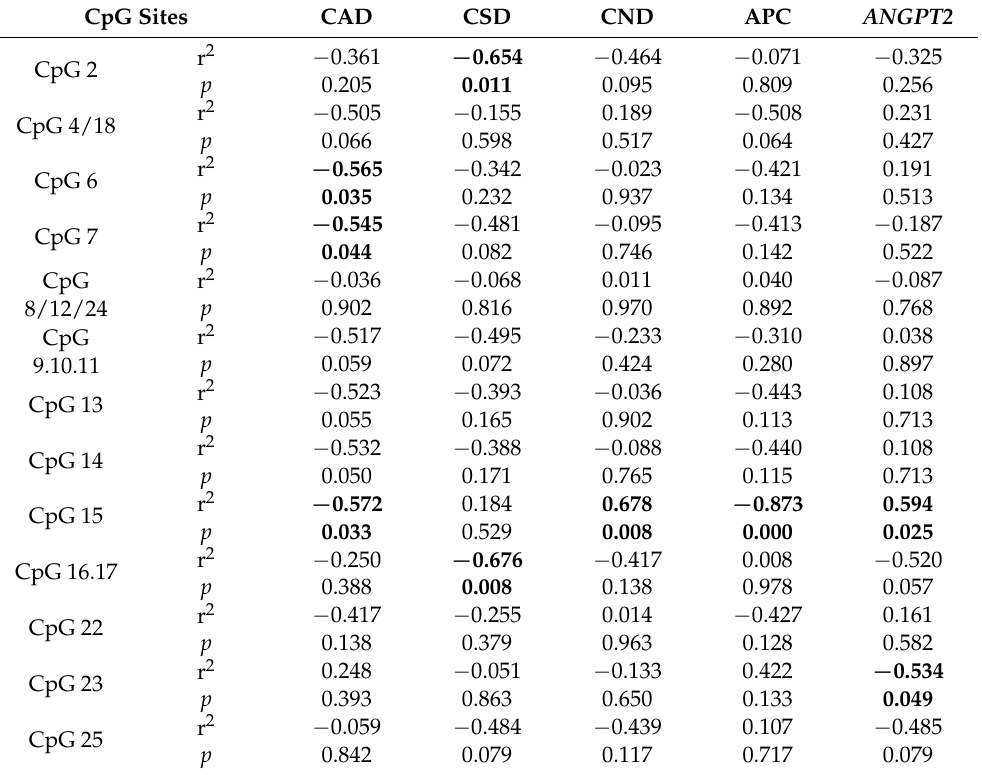
Table 4. Correlation of vascular distribution with the DNA methylation of CpG sites at ANGPT2 in the caruncle during the early stage of